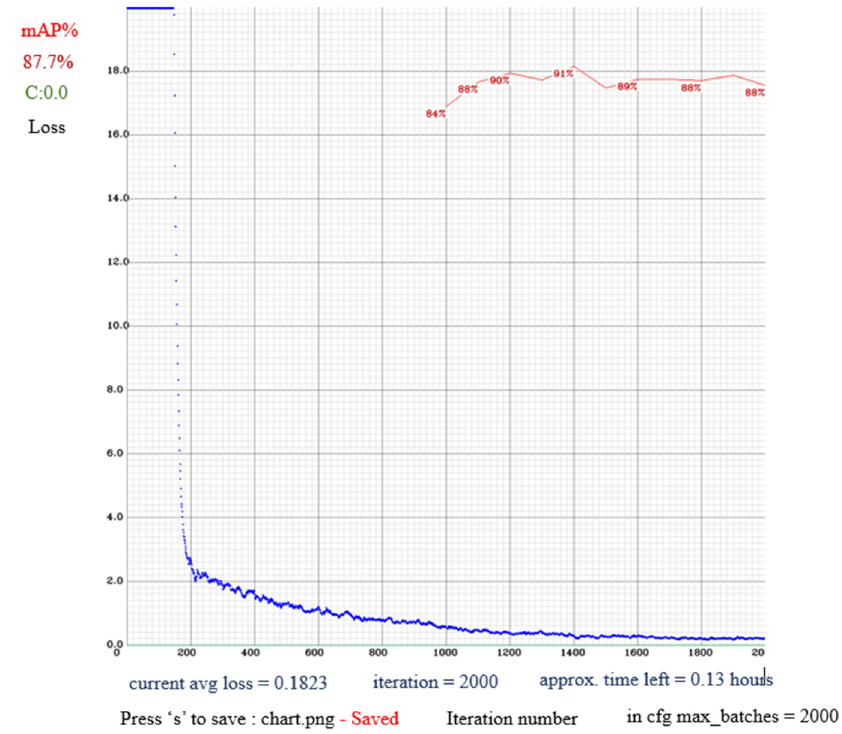
Figure 6. mAP% in the loss chart.